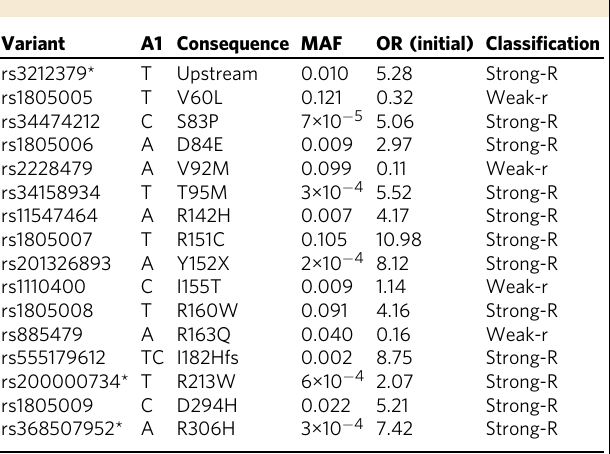
identi fi ed red-hair alleles are marked with an asterisk